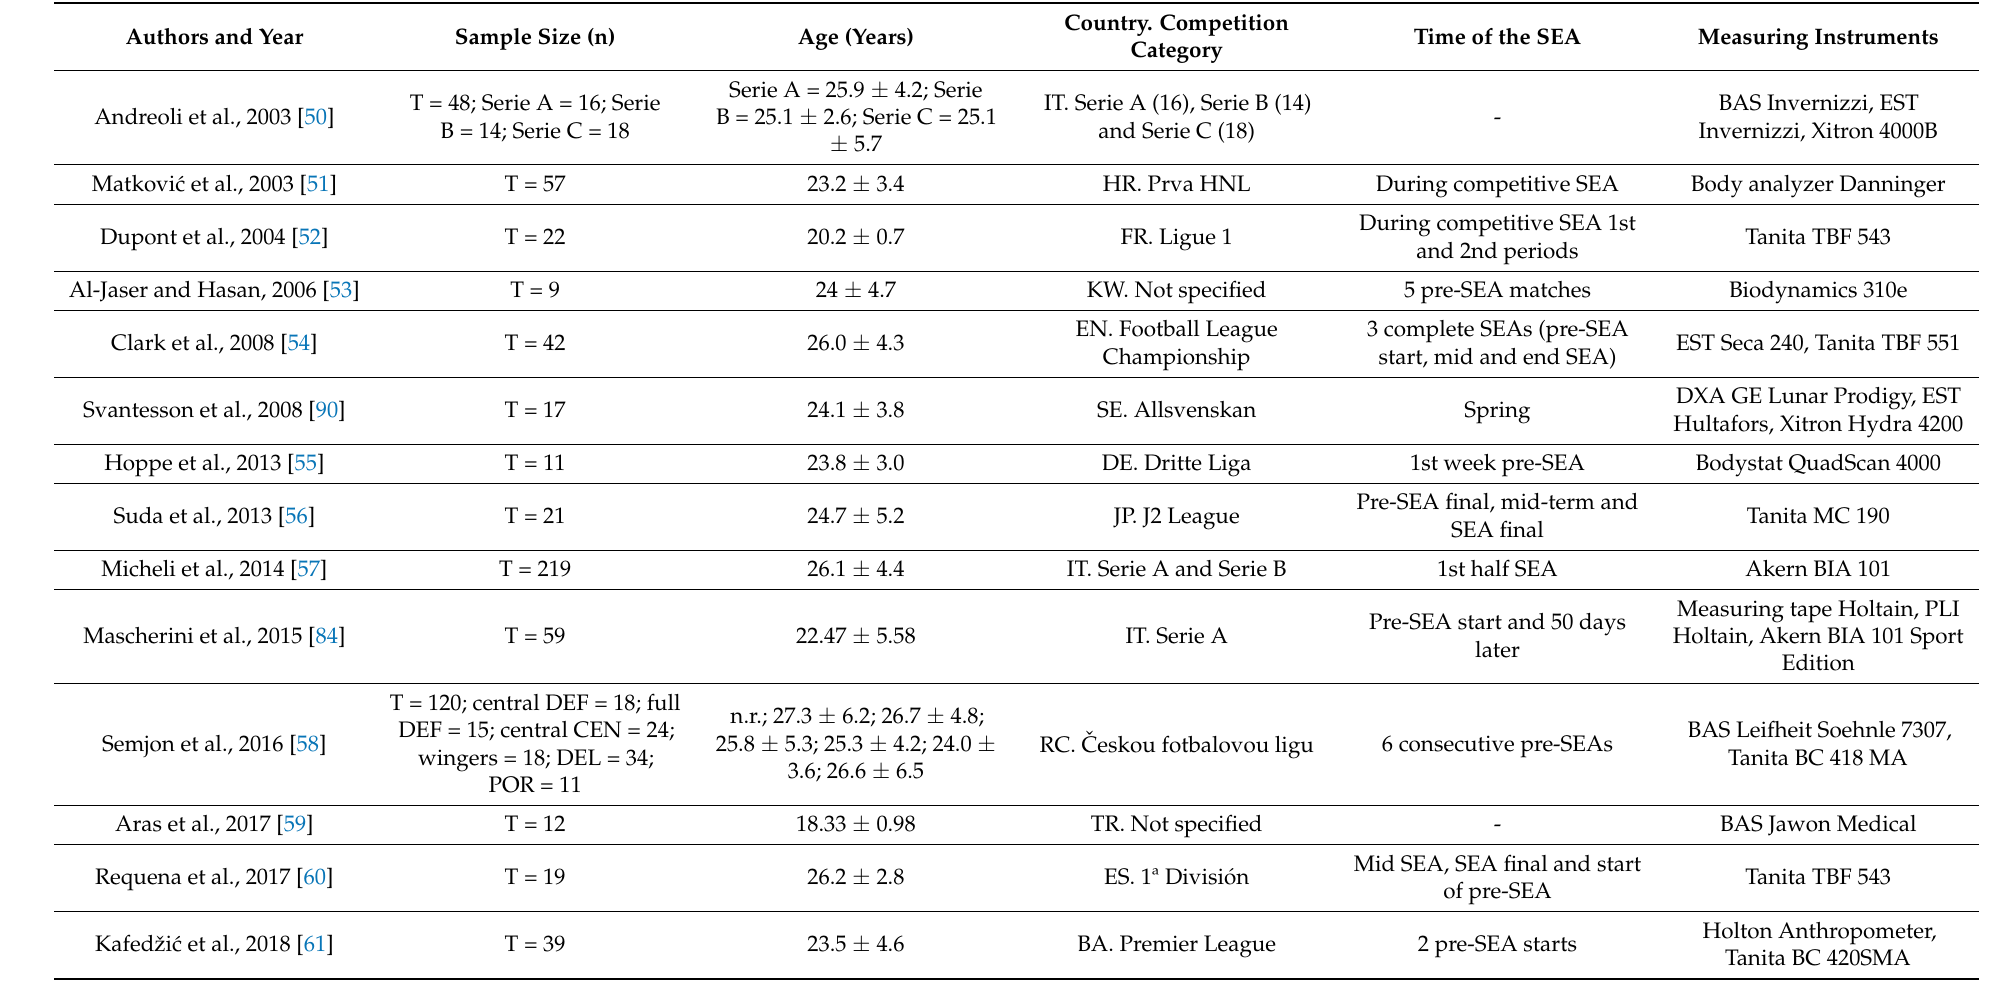
Table 3. Descriptive characteristics of the included studies with